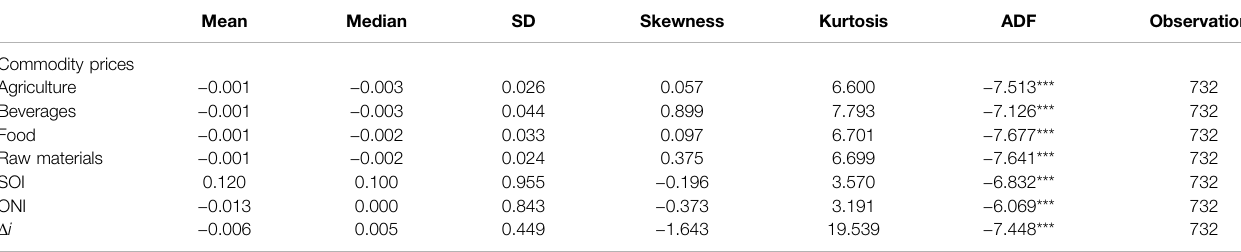
TABLE 1 | Descriptive statistics.